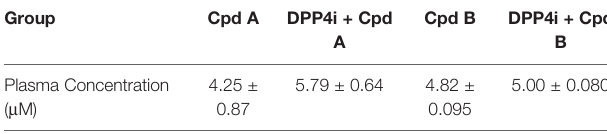
Data expressed as mean (6 mice) ±